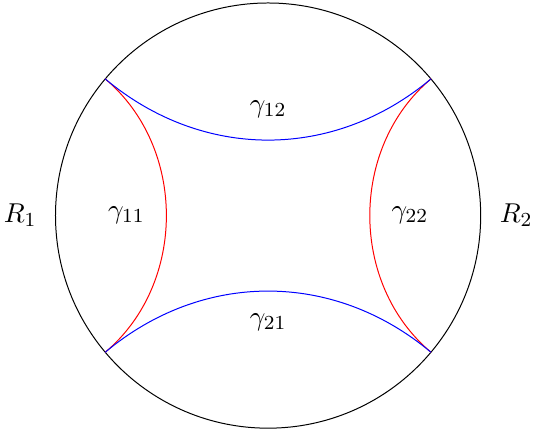
Figure 5 . Two competing extremal surfaces when R = R 1 ∪ R 2 is a pair of intervals on the boundary of the AdS 3 vacuum. The homotopic RT surface γ d = γ 11 ∪ γ 22 and the non-homotopic RT surface γ o = γ 12 ∪ γ 21 are shown respectively in red and blue. The case shown sits precisely at the RT phase transition, where γ d and γ o are related by a π/ 2